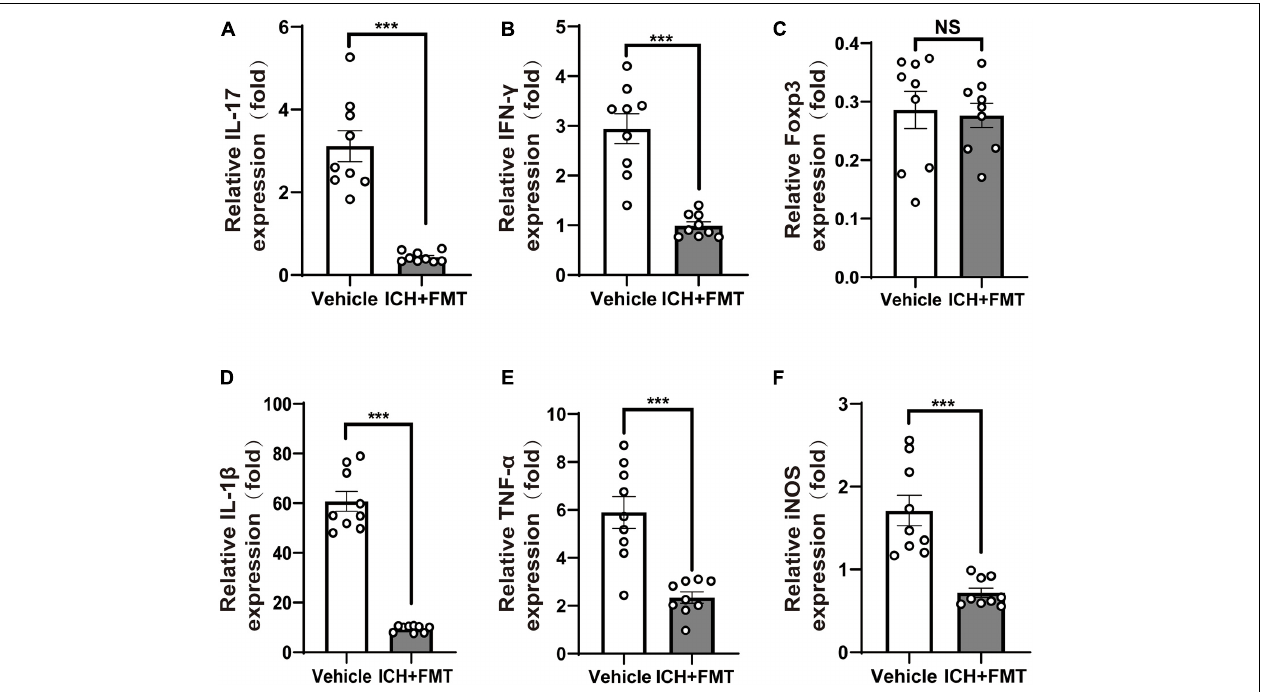
FIGURE 5 | Healthy fecal microbiome transplantation decreases neuroinflammation after ICH. (A–C) Recolonizing ICH mice with the gut microbiota obtained from healthy donor mice significantly decreased the gene expression level of IL-17 and IFN- γ compared with recipient of PBS ICH mice 14 days after ICH, but there was no significant change in the gene expression of Fxop3 ( n = 3 per groups, 3 individual experiments). (D–F) Relative gene expression levels of IL-1 β , tumor necrosis factor-alpha, and inducible nitric oxide synthase in the hemorrhagic basal ganglia. Recolonization with microbiota from healthy donor mice markedly suppressed IL-1 β , tumor necrosis factor-alpha, and inducible nitric oxide synthase expression compared with ICH recipient of PBS ICH mice 14 days after ICH ( n = 3 per groups, 3 individual experiments). Data are expressed as the mean ± SEM. *** P < 0.001 vs . vehicle group.